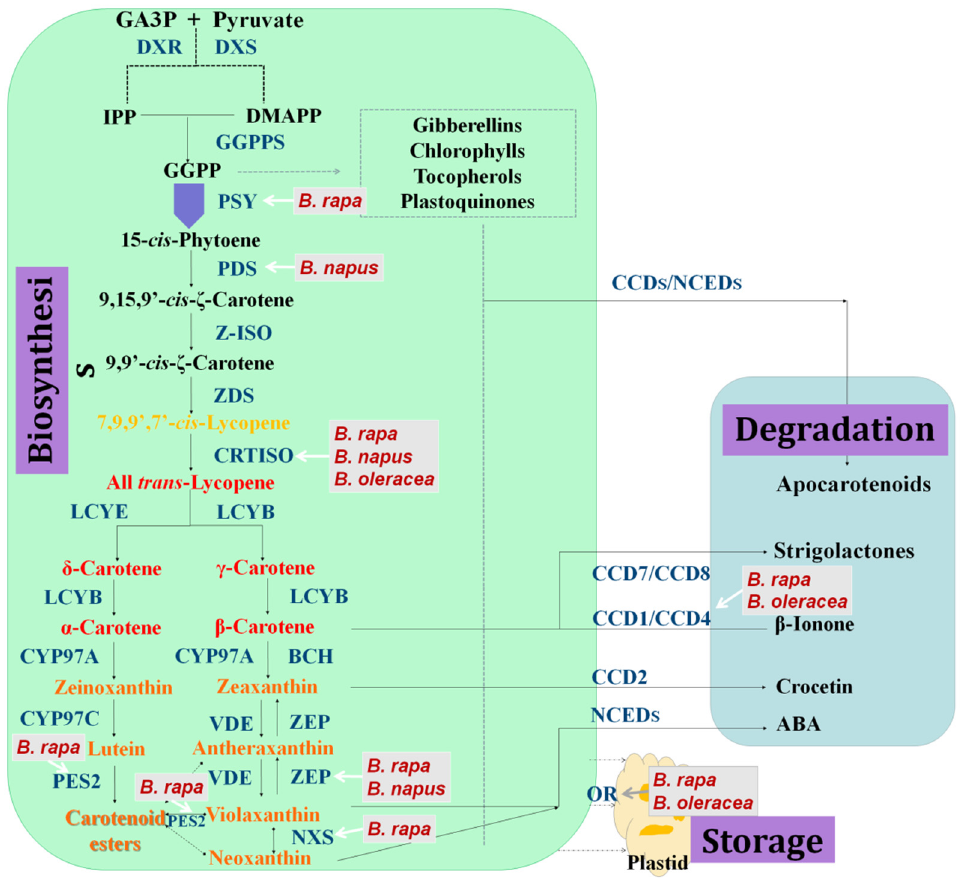
Figure 1. Overview of carotenoid metabolism in Brassica .